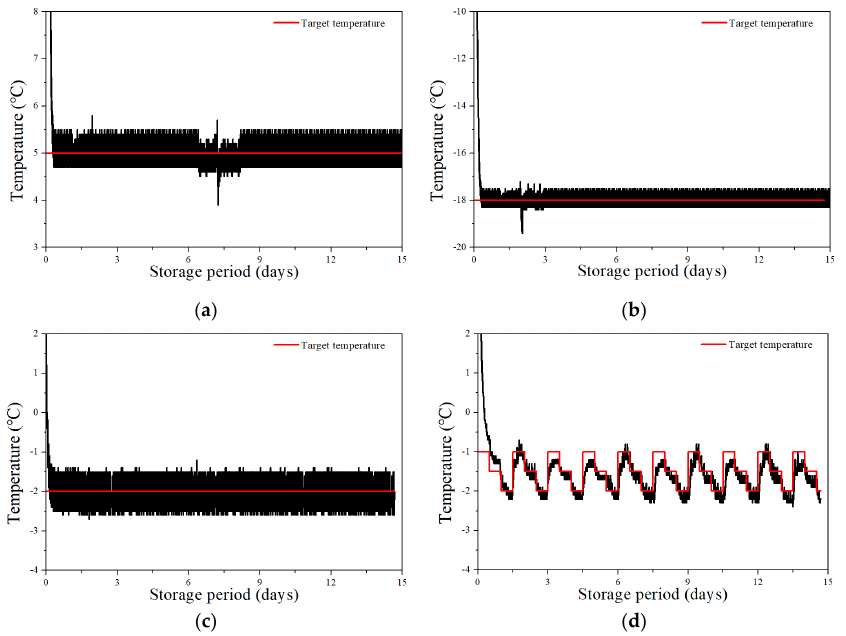
Figure 1. Time − temperature profiles of the target temperature and raw laver samples stored under Figure 1. Time-temperature profiles of the target temperature and raw laver samples stored un- the conditions of ( a ) refrigeration, ( b ) freezing, ( c ) constant −− temperature supercooling, and ( d ) su- der the conditions of ( a ) refrigeration, ( b ) freezing, ( c ) constant-temperature supercooling, and percooling using a stepwise cooling algorithm. ( d ) supercooling using a stepwise cooling